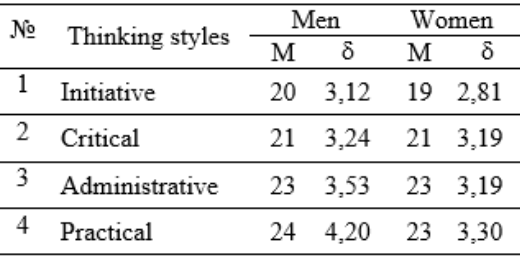
Table 4. Values of technique scales consistency